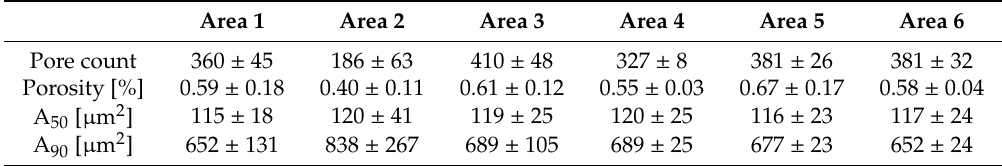
Table 1. Local porosity results for the sample with the manufacturing parameters t = 30 µ m, P = 400 W, v = 300 mm / s, h = 60 µ m (compare Figure 9a,b,e,f). For the analysis the LOM, cross-sections were divided into 6 equal areas (see Figure 9f). The total amount of pores, the porosity, and the A 50 and A 90 values were calculated as dependent on the di ff erent areas for 4 cross-sections. (A 90 : 90% of the 2D-pore areas are smaller than the given value, 10% are